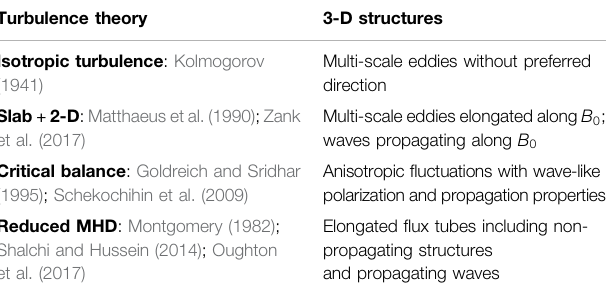
Frontiers in Astronomy and Space Sciences |